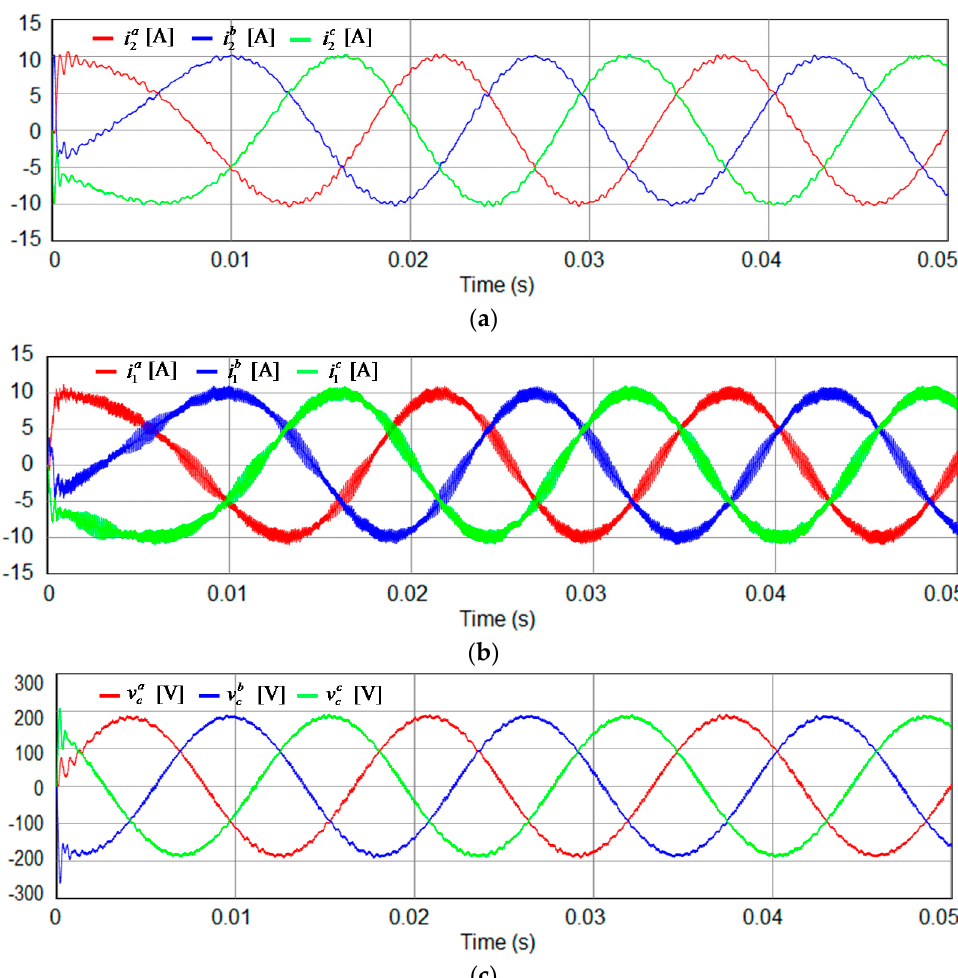
Figure 6. Simulation results for three-phase variables using the proposed discrete-time integral state feedback control scheme with state observer. ( a ) Three-phase grid-side current waveforms; ( b ) Three-phase inverter-side current waveforms; ( c ) Three-phase capacitor voltage